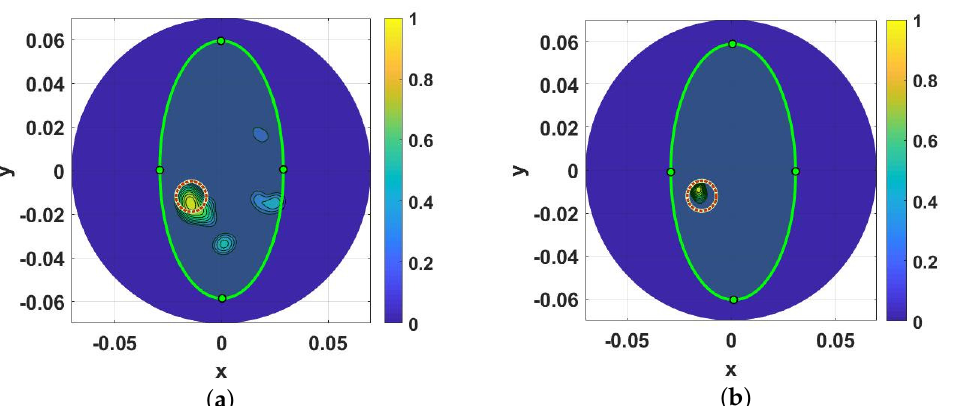
Figure 5. Obtained microwave images of MammoWave device phantom experiments using frequency 1 GHz to 6.5 GHz, ( a ) applying “rotation subtraction” method, ( b ) employing the “ideal” method. The light green ellipse indicates the phantom region, while the area marked with a red circle shows the exact position of inclusion and the dimension of the circle is in relation to the dimension of the inclusion. Axes scales are